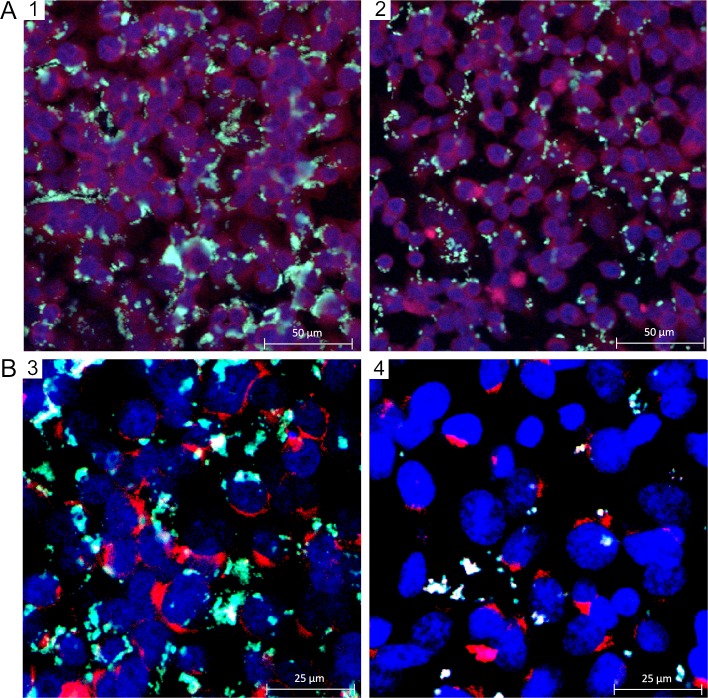
Representative confocal laser scanning microscopy images of FITC labeled P. gingivalis during different incubation protocols with KB cells.(A) Coincubation (90 min) of KB cells with FITC-labeled P. gingivalis (BCR 100:1) and RA1 (10 μg/mL); 1: untreated control 2: RA1 (10 μg/mL). (B) Preincubation of KB cells with RA1 (10 μg/mL) for 12 h and subsequent infection with P. gingivalis (BCR 100:1) for 90 min; 3: untreated control; 4: RA1 (10 μg/mL). Bacteria are stained with FITC (green), nuclei of KB cells with DAPI (blue) and endosomes with Dextran Texas Red (red).